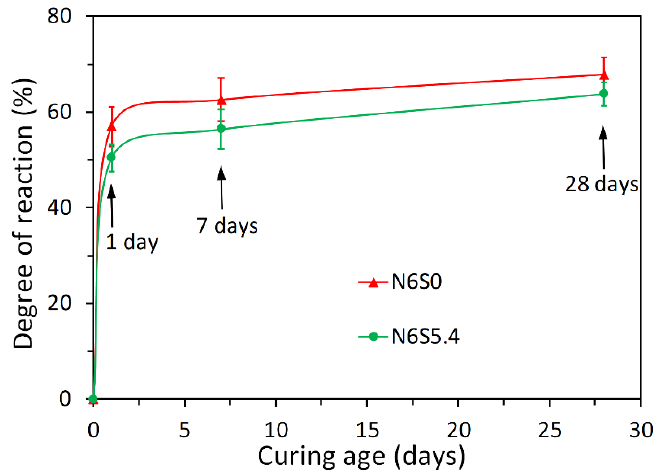
Figure 12. Degree of reaction of slag, derived from SEM-image analysis, for N6S0 and N6S5.4.